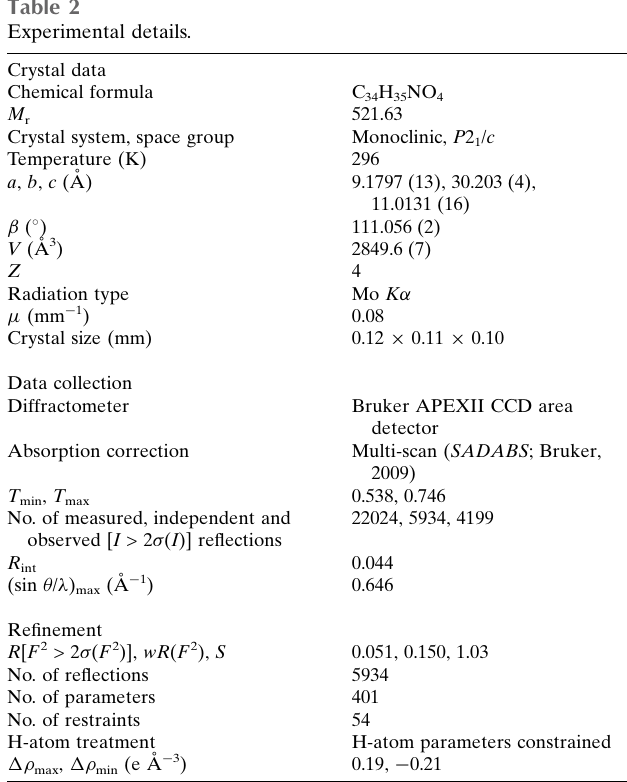
Table 2 Experimental details.